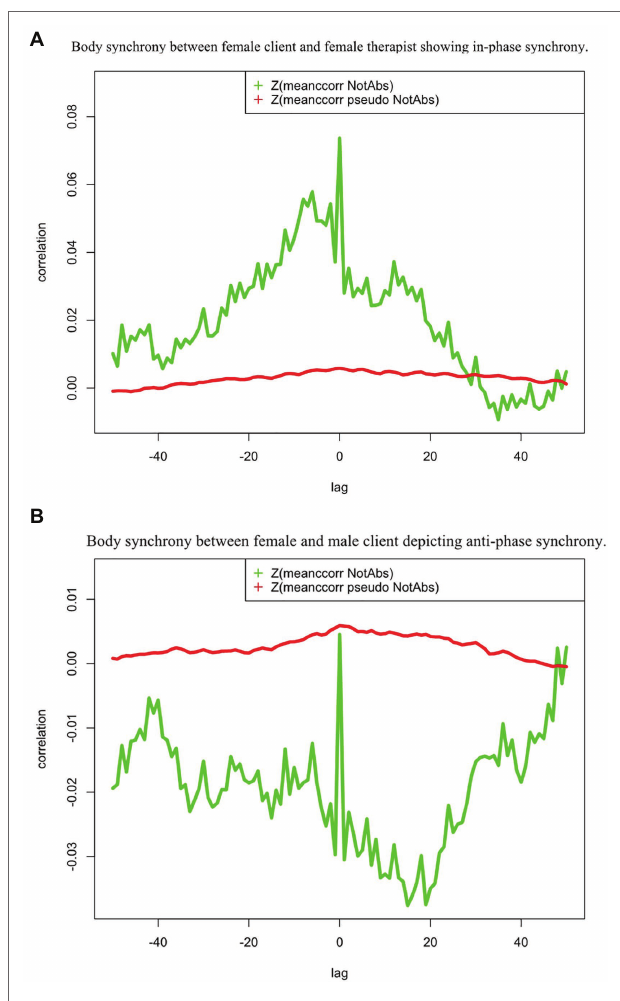
FIGURE 1 | Both plots represent dyadic synchrony from one couple therapy session. The green graph depicts the real nonverbal synchrony cross-correlations as a function of the respective lag. The red graph is the average of all surrogate time series and represents the pseudo- synchronies. The upper panel (A) shows body synchrony between the female client and female therapist in one session. The green graph is above the red graph showing significant in-phase synchrony (positive correlations). In the lower panel (B) body synchrony between the clients in the same session is depicted. The green graph is below the red pseudo-synchrony graph, showing anti-phase synchrony (negative